Question: What does this figure show? Answer in one sentence.
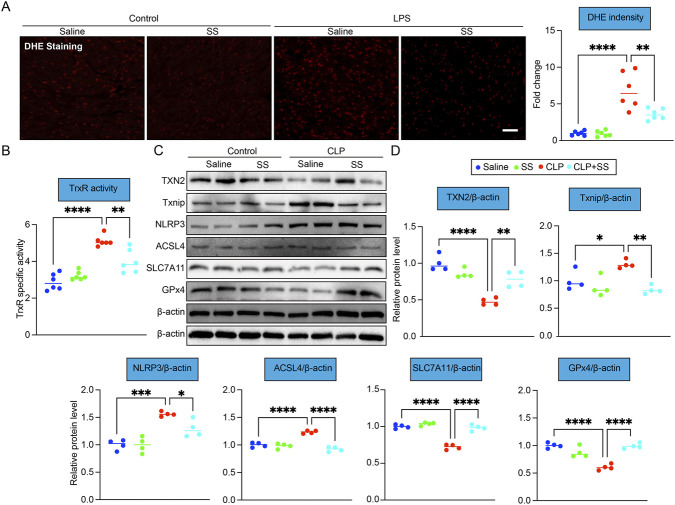
Answer: SS reduces oxidative stress and ferroptosis by regulating TXN2–TXNIP–NLRP3. (A) DHE staining of heart sections (right, n = 4, scale bar = 20 μm); quantification of DHE intensity (left, n = 4). (B) TrxR activity (n = 6). (C) Immunoblotting analysis of TXN2, TXNIP, NLRP3, ACSL4, SLC7A11, GPX4, and β-actin (n = 4). (D) Relative protein levels of each blot (n = 4). The results are expressed as the mean ± SD. * p < 0.05, ** p < 0.01, *** p < 0.001, and **** p < 0.0001.